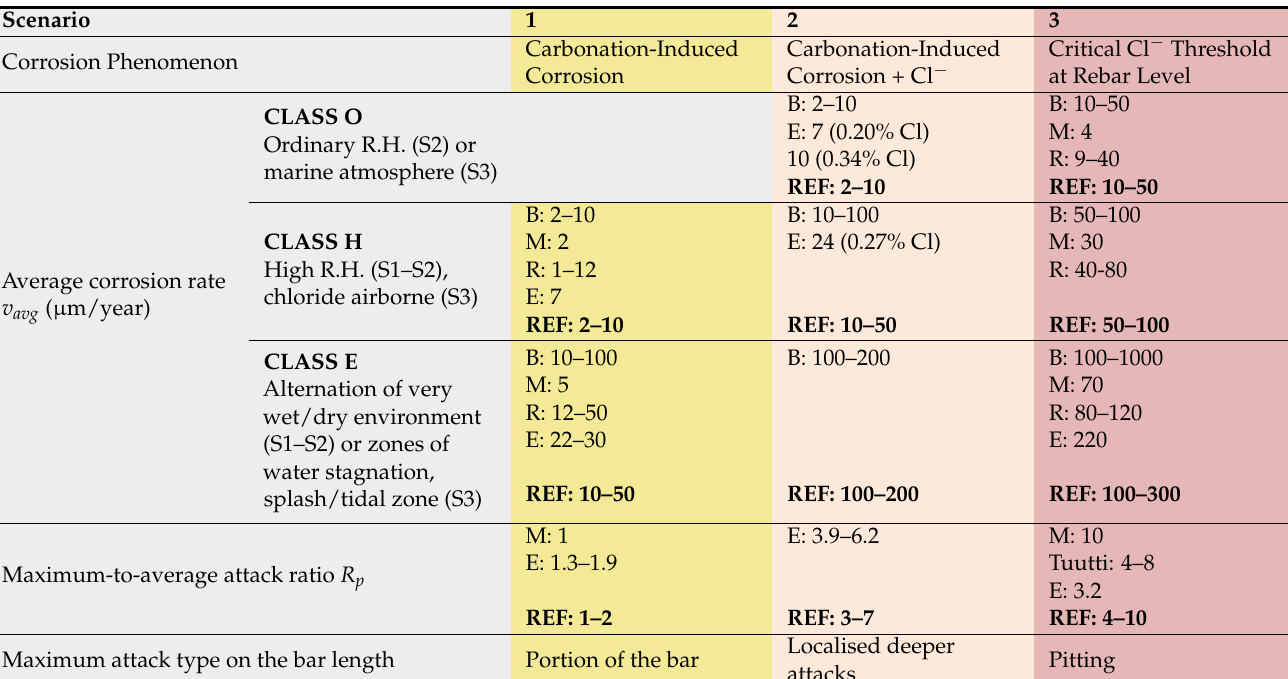
Table 6. Characteristics of the corrosion attack in each corrosion risk scenario (data adapted from the literature are named as ‘B’ [2], ‘M’ [22], and ‘R’ [23]; data estimated from survey on existing structures are reported with ‘E’ [12]; final values to be adopted as representative values are indicated with